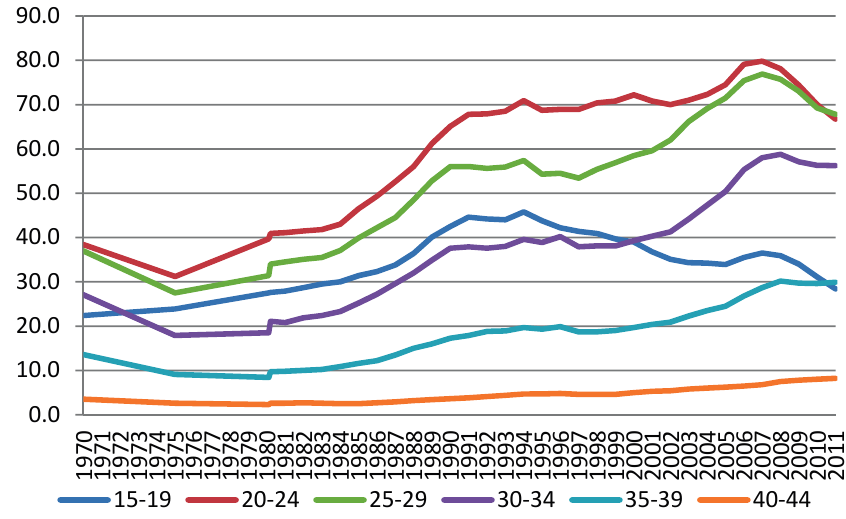
Figure 1. U.S. Birth Rates for Unmarried Women by Age of Mother (Source: Table 16 in